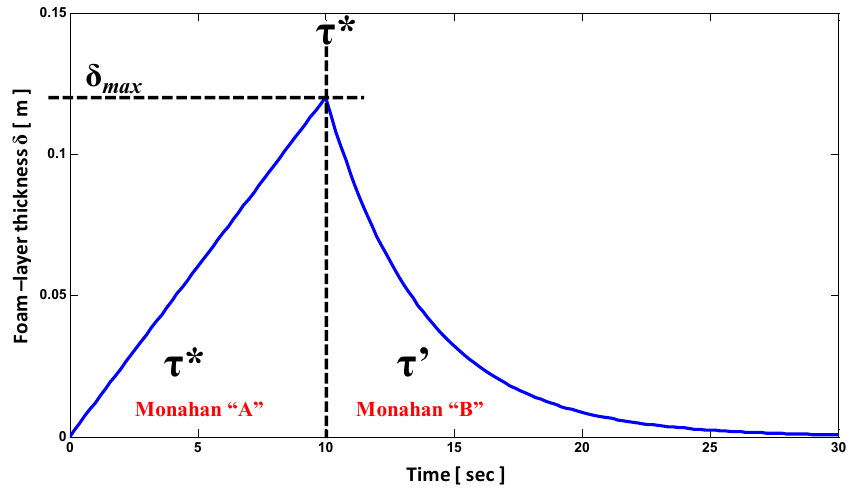
Figure 4. Time evolution foam-layer thickness (after [19], modified).